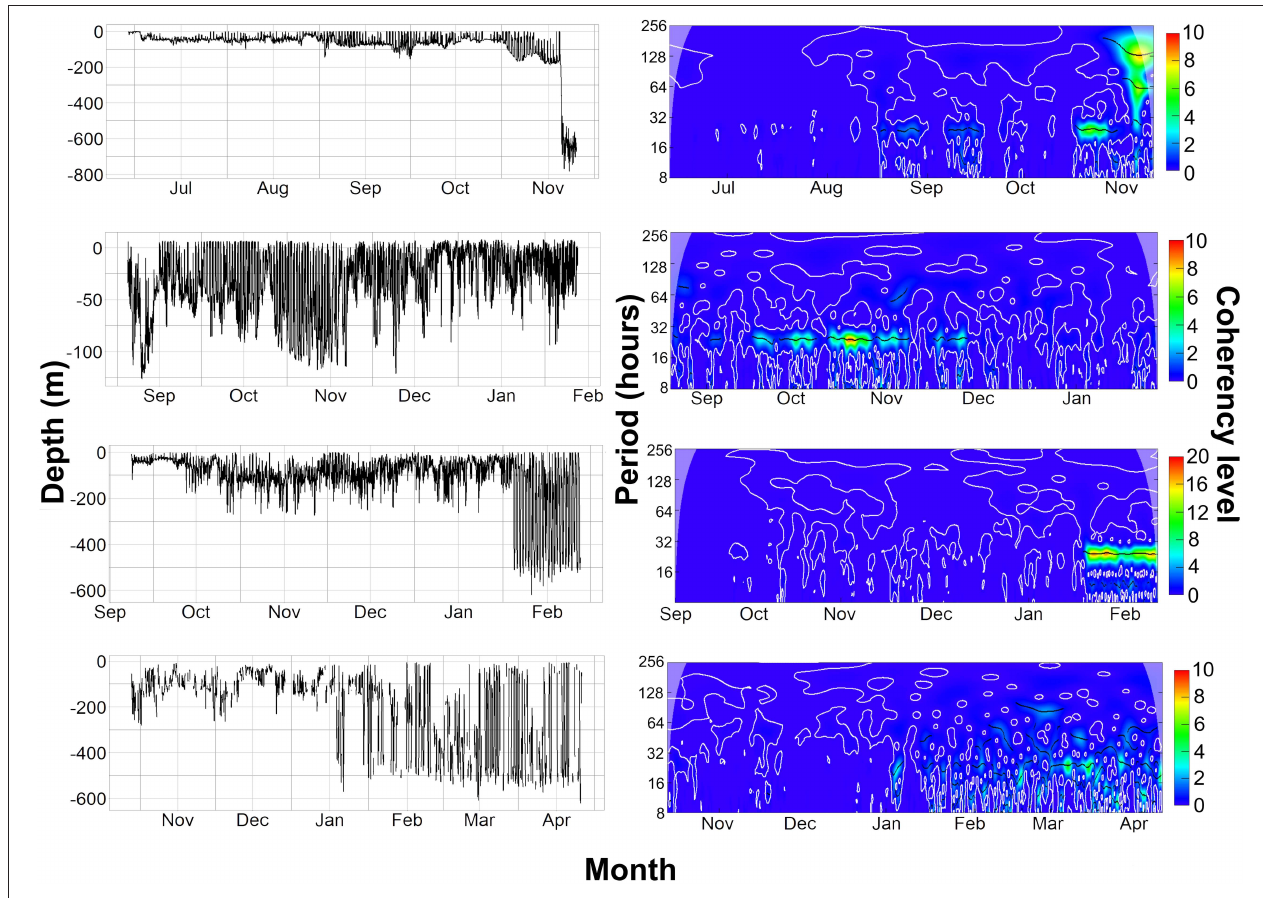
FIGURE 7 | (Left) Raw depth data from the archival and PSAT tags. (Right) Wavelet analysis on 30-min averaged depth data from the archival and PSAT tags, Coherency level is a reflection on the strength of the cyclic pattern detected. 5159, 2036, and 153233 are all on same scale of 0–10 coherency level, 2089 is 0–20 due to stronger cyclic pattern detected. The top row shows data from tag 5159 (Female), second row is tag 2036 (Male), third row is 2089 (Male), and last row is 153,233